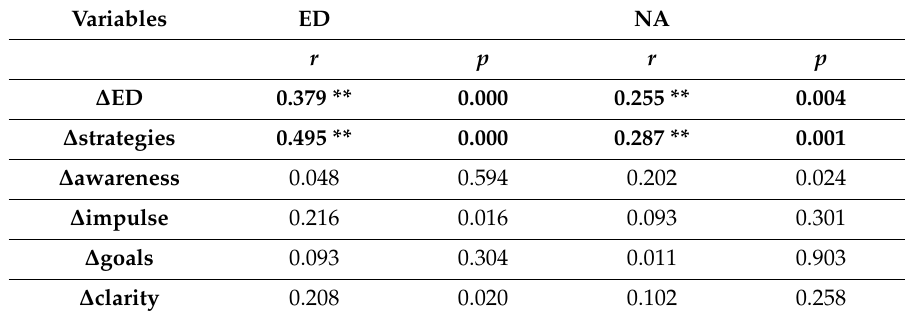
Table 12. Correlations between variables (Pearson’s coe ffi cients): ∆ / ED; ∆ / NA; healthy group ( n = 146);